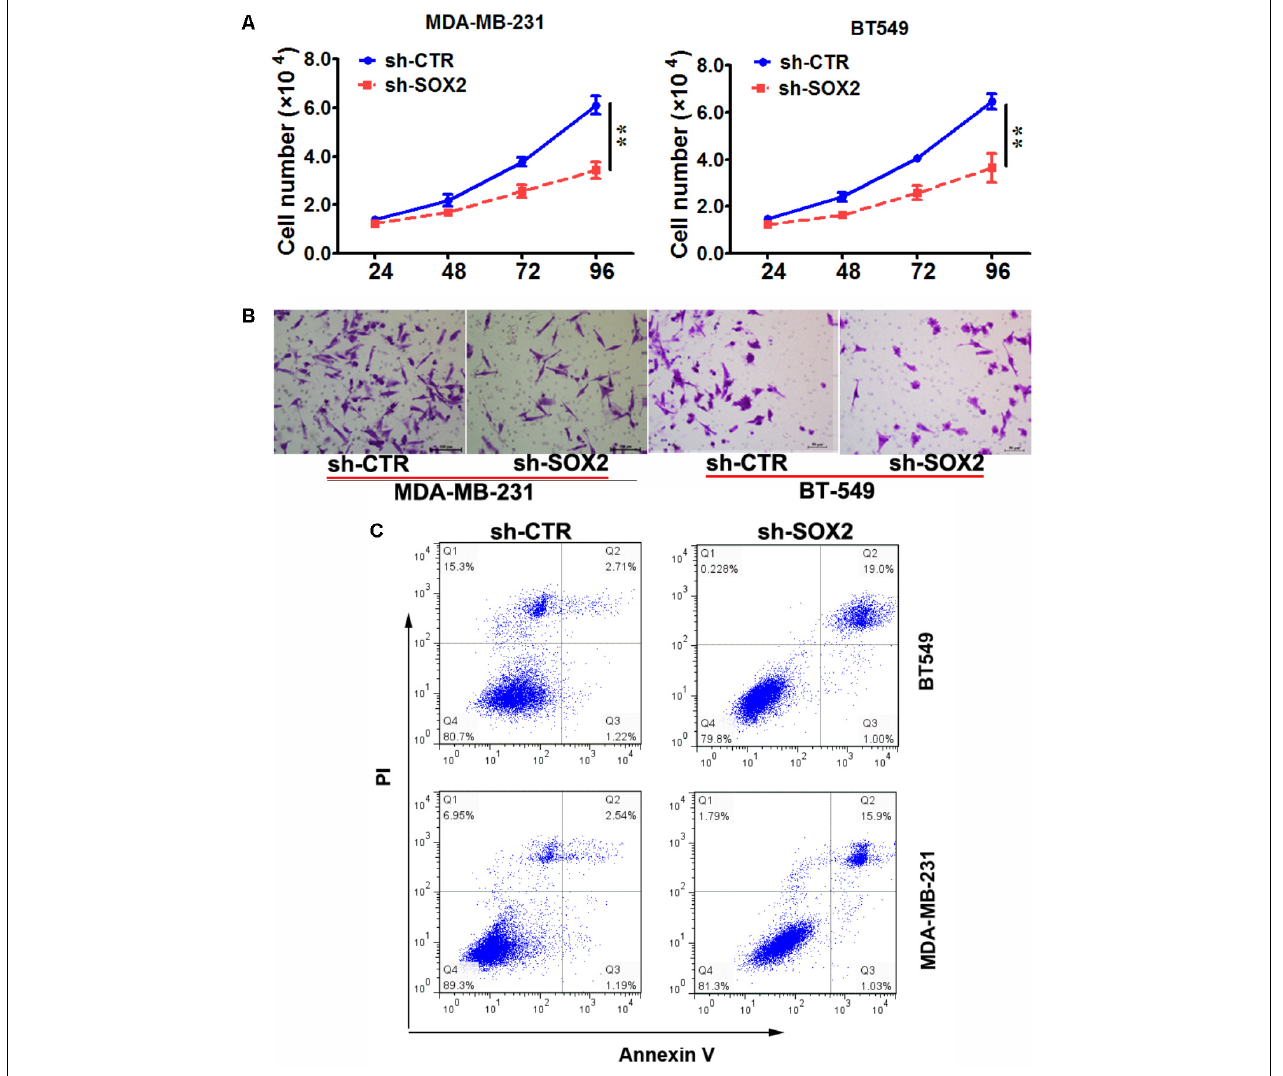
FIGURE 2 | SOX2 inhibition reduced cell proliferation and invasion, and promoted cell apoptosis in TNBC. (A) MDA-MB-231 and BT-549 cells were infected with sh-SOX2 or sh-control lentivirus. Cell number was counted at 24, 48, 72, 96 h after infection ( ∗∗ p < 0.01). (B) The invasion ability of MDA-MB-231 and BT-549